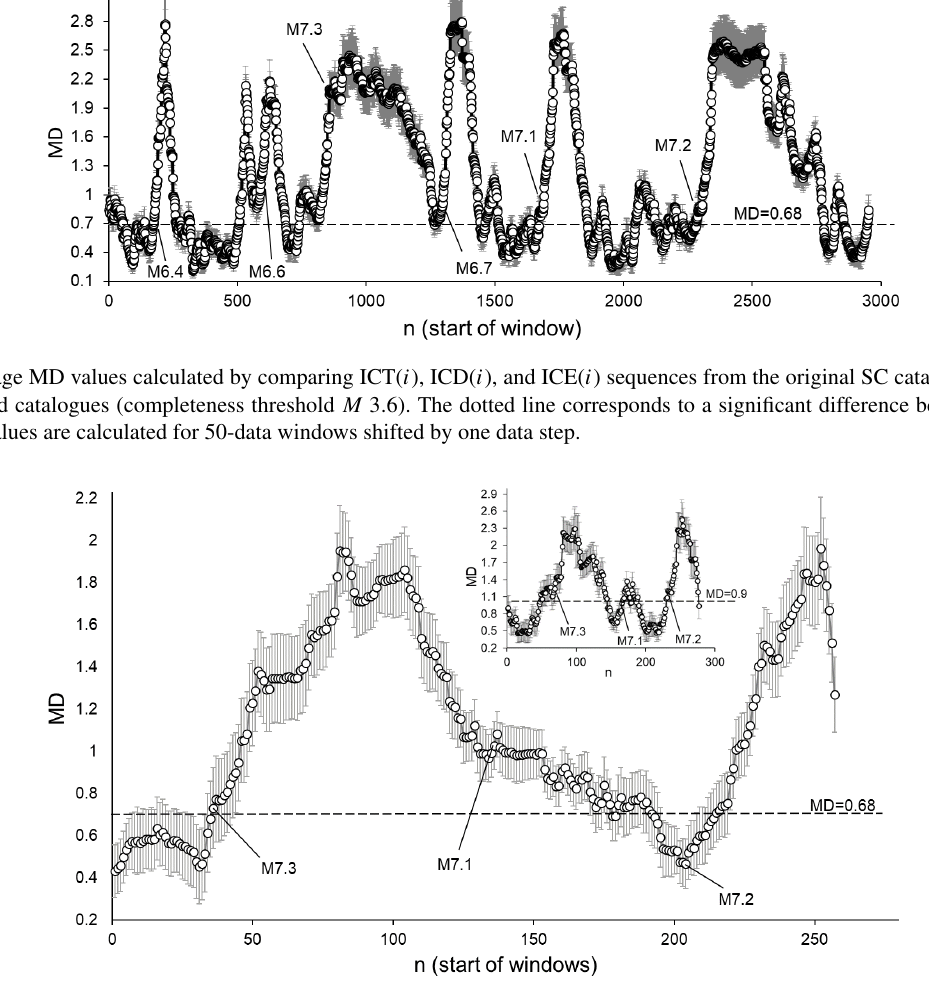
Figure 17. Average MD values calculated by comparing ICT( i ), ICD( i ), and ICE( i ) sequences from the original SC catalogue and from the set of randomised catalogues (completeness threshold M 4 . 6). The dotted line corresponds to a significant difference between windows at p = 0 . 01. MD values are calculated for 50-data windows shifted by one data step. The inset shows results calculated for 30-data windows shifted by one data